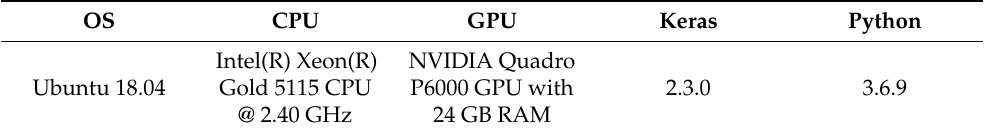
Table 1. Running and testing